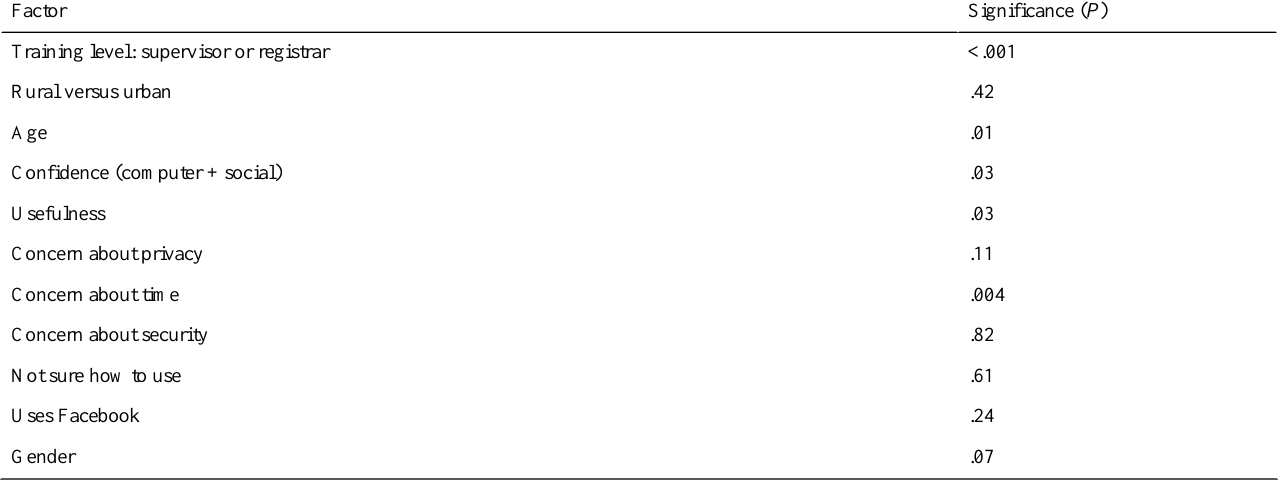
Table 6. Factors correlated with the intention to use a private network for work or training